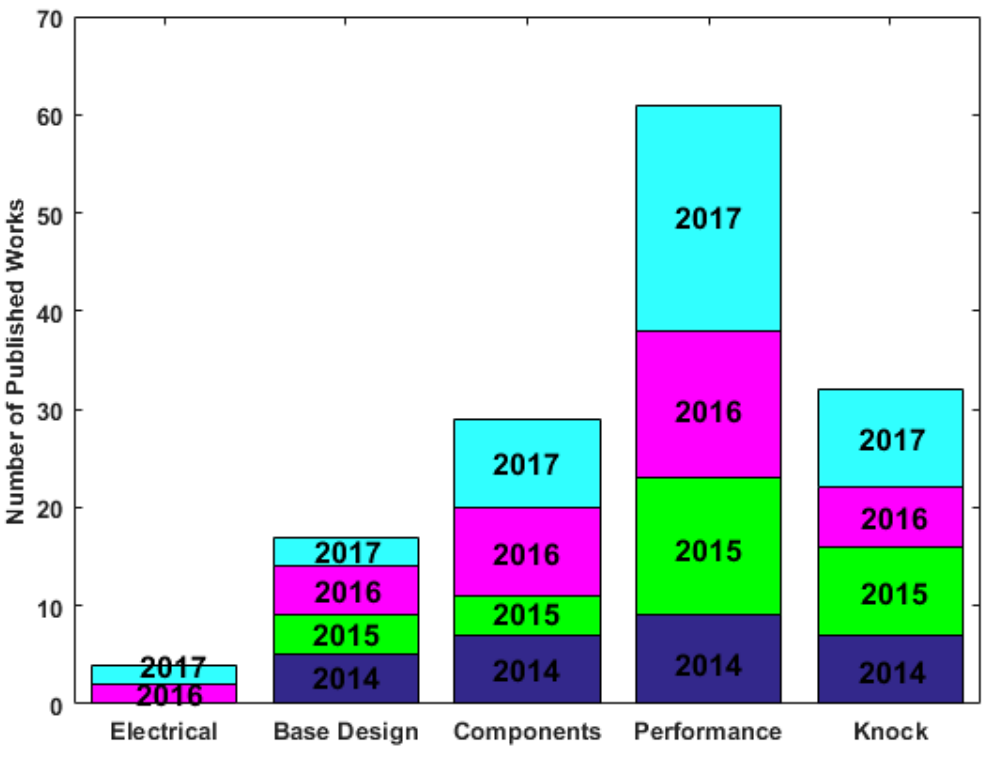
Figure 3. Trend of focusing on different fields of engine downsizing